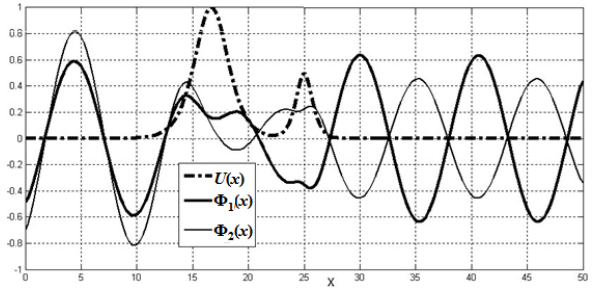
Figure 1: Fundamental solutions of stationary Schrödinger equation for barriers of given